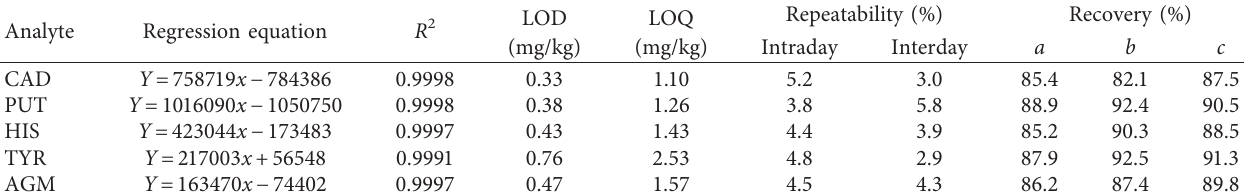
Table 4: Performance of the ion-pair HPLC method for biogenic amine determination in canned sardine. Analyte Regression equation R 2